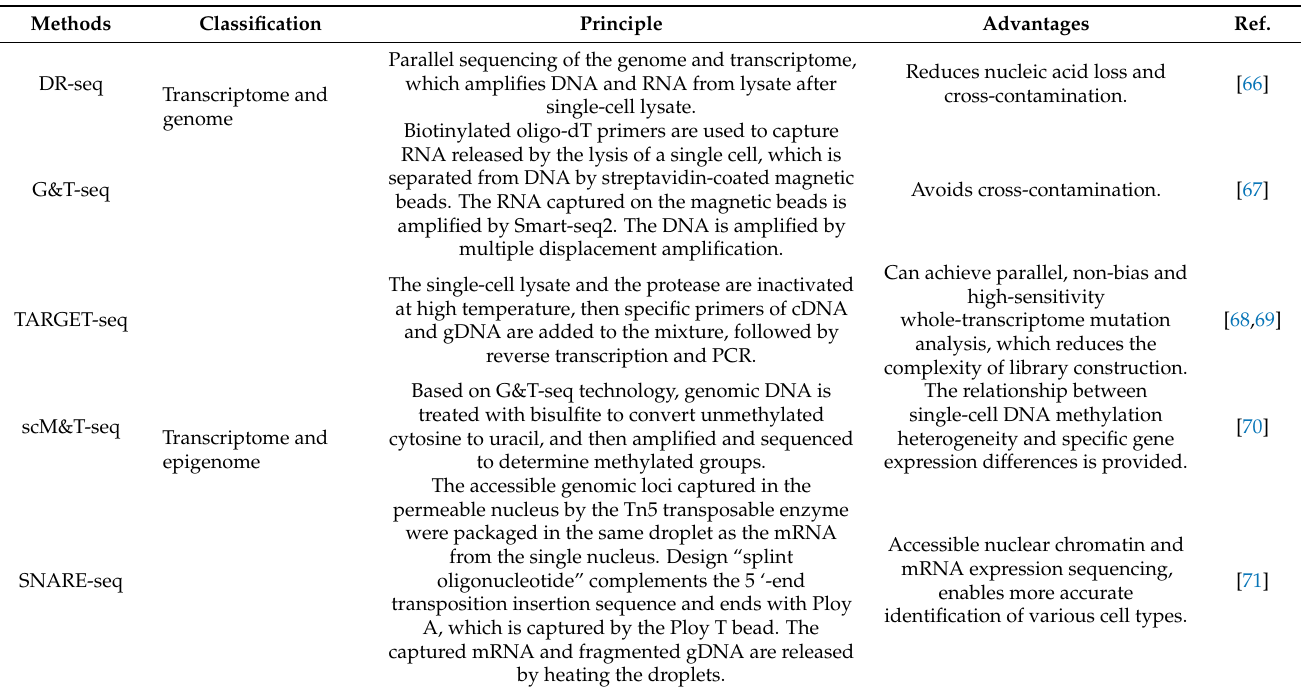
Table 7. Single-Cell Multi-omics Combined